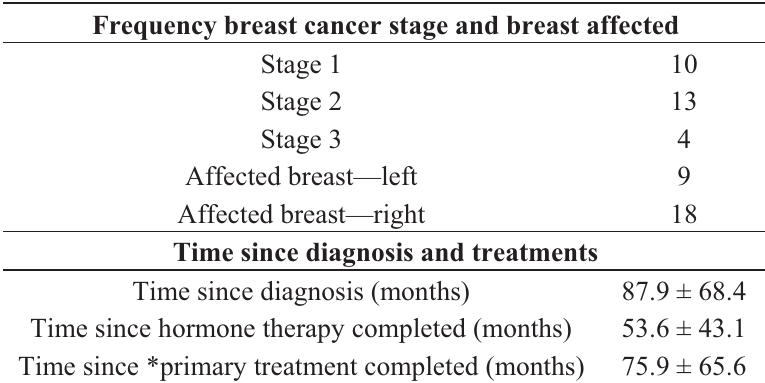
Table 2. Participant Cancer Related Characteristics ( N =